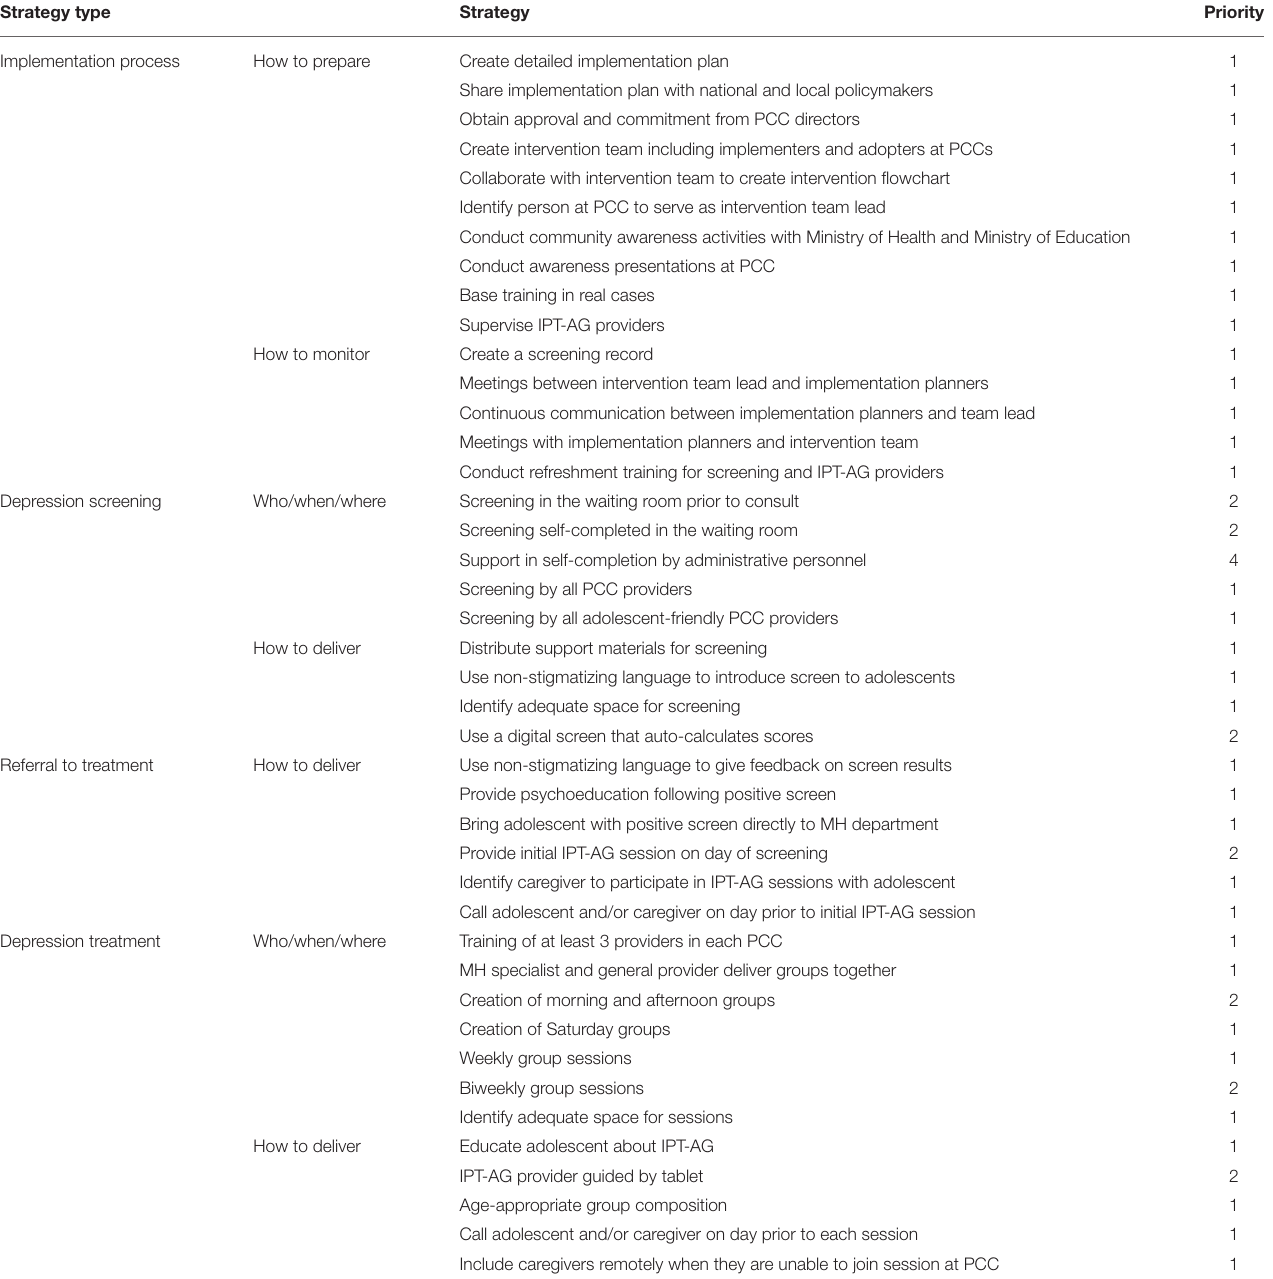
TABLE 3 | Implementation strategies and their prioritization for integrated adolescent depression services in Mozambican primary care. Strategy